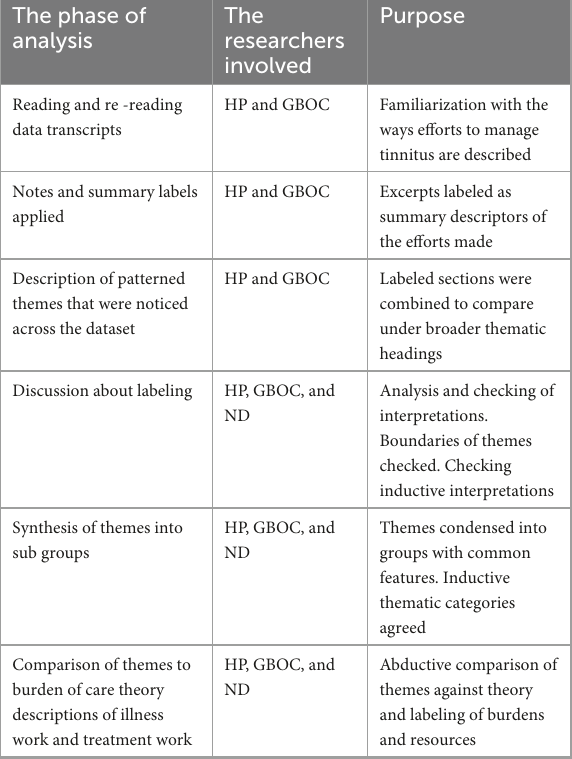
TABLE 1 Summary table describing the phases of data